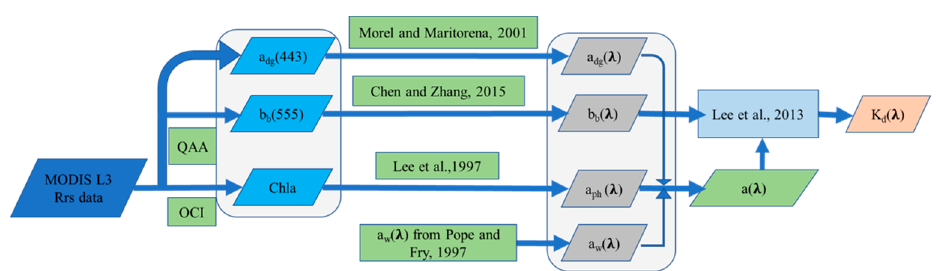
Flowchart for retrieving spectral K d using MODerate Imaging Spectroradiometer (MODIS) data.